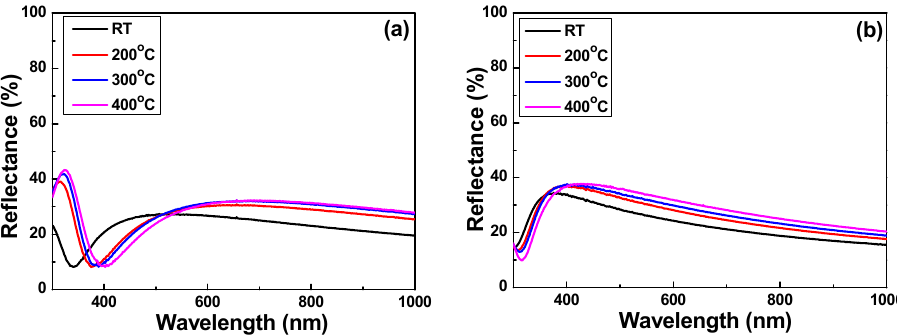
Figure 5. Measured reflectance of Nb 2 O 5 thin films as a function of deposition temperature and O 2 ratio. ( a ) O 2 ratio 10% and ( b ) O 2 ratio 20%, respectively. Table 3. Average reflectance, minimum reflectance, and light wavelength to reveal the minimum reflectance of Nb 2 O 5 thin films.